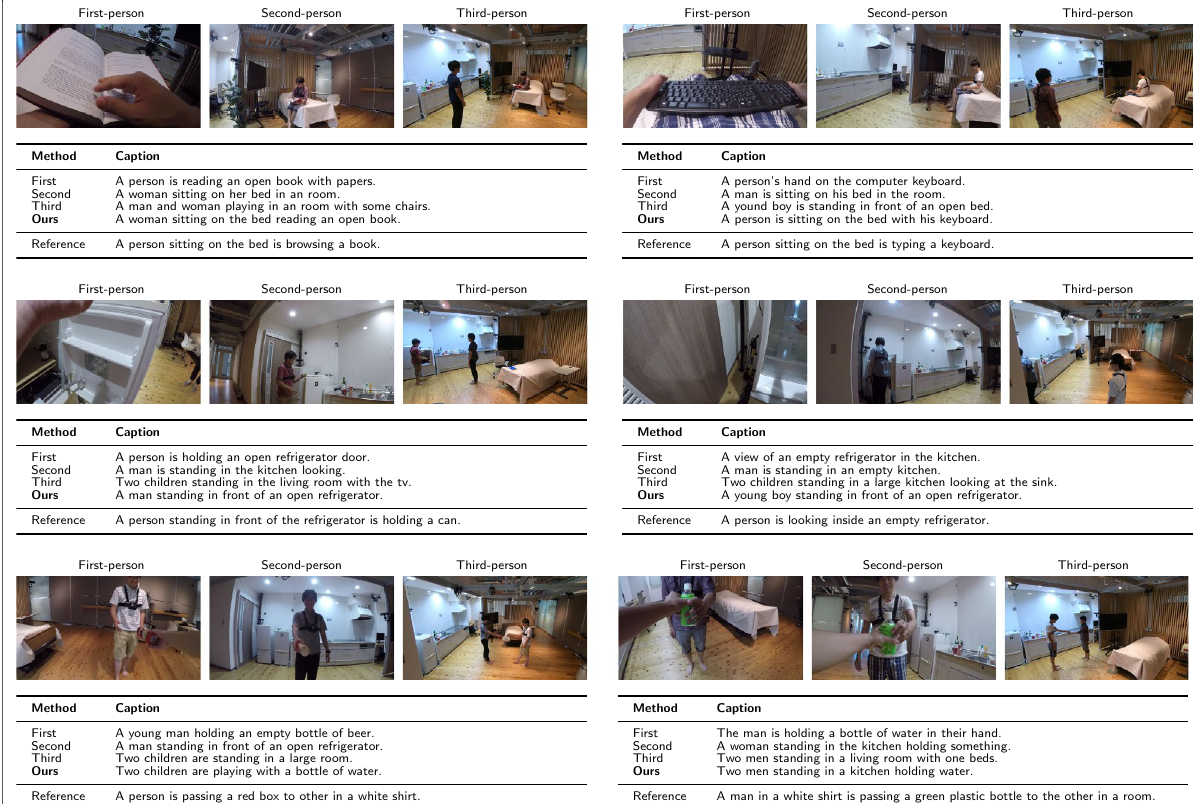
Fig. 11 Example captions with the single perspective model and our proposed model. Methods “First”, “Second”, and “Third”: UpDown model with a single image. Method “Ours”: KMeans model with three types of images. All results are generated with beam search